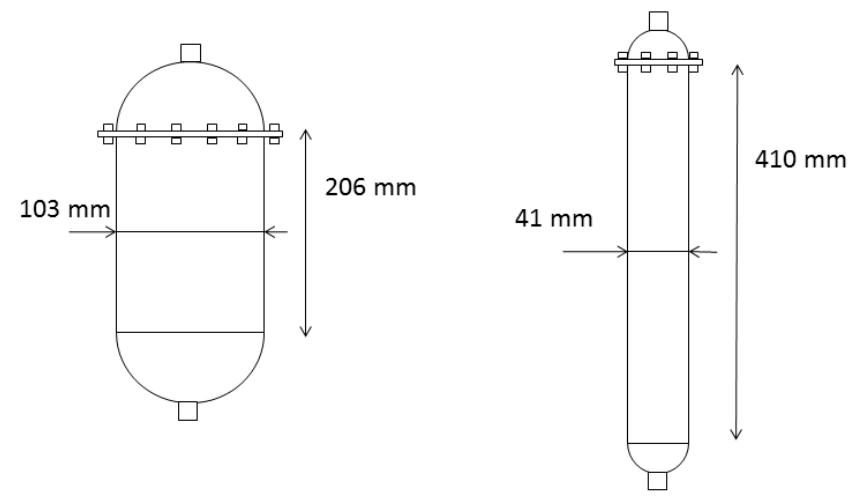
Figure 3. Reactors designed for the process.